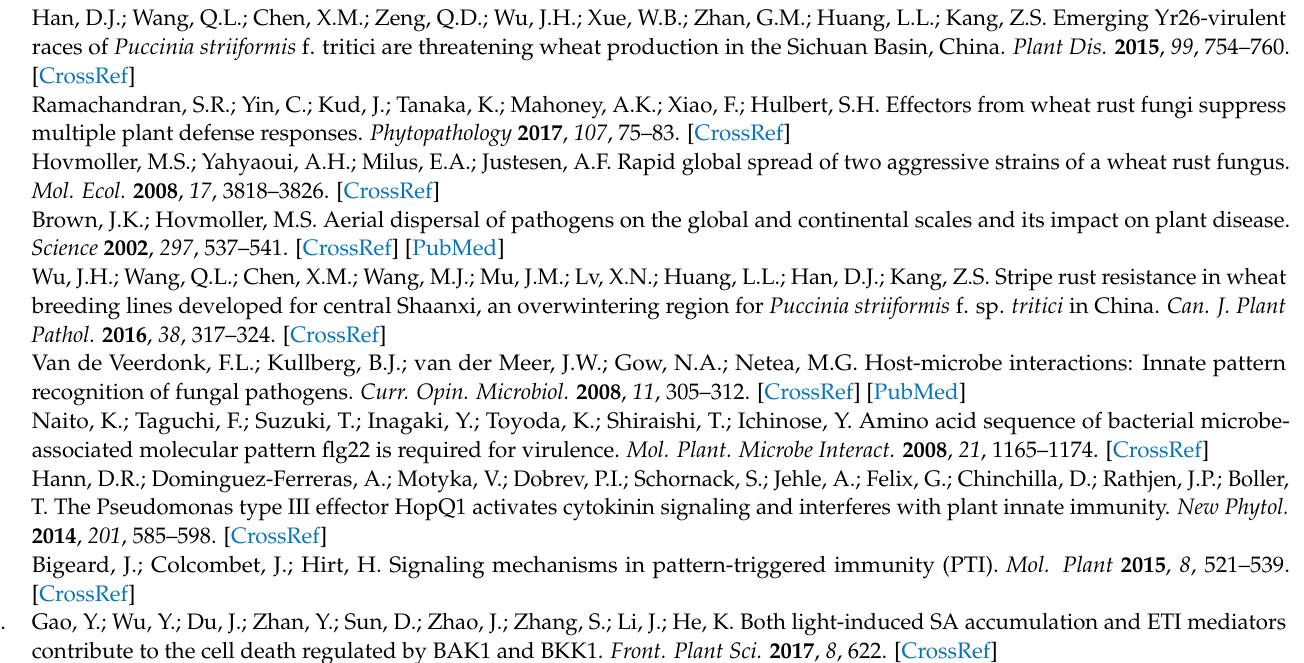
candidate effectors, Table S3: The Primer for qRT-PCR, Table S4: The Primer for vector